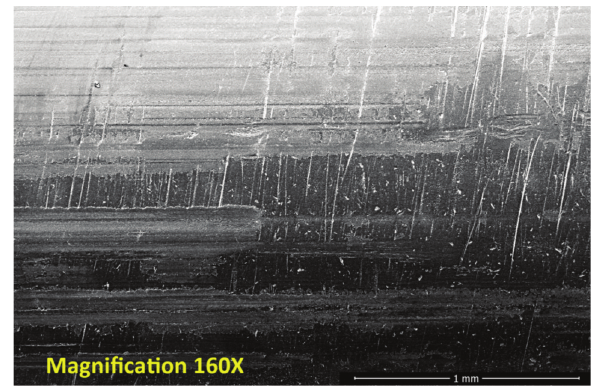
SEM image from inferior ridge of the FNE from Patient 2 Fig. 6: with medial migration showing both transverse and longitudinal scratch marks (magnification